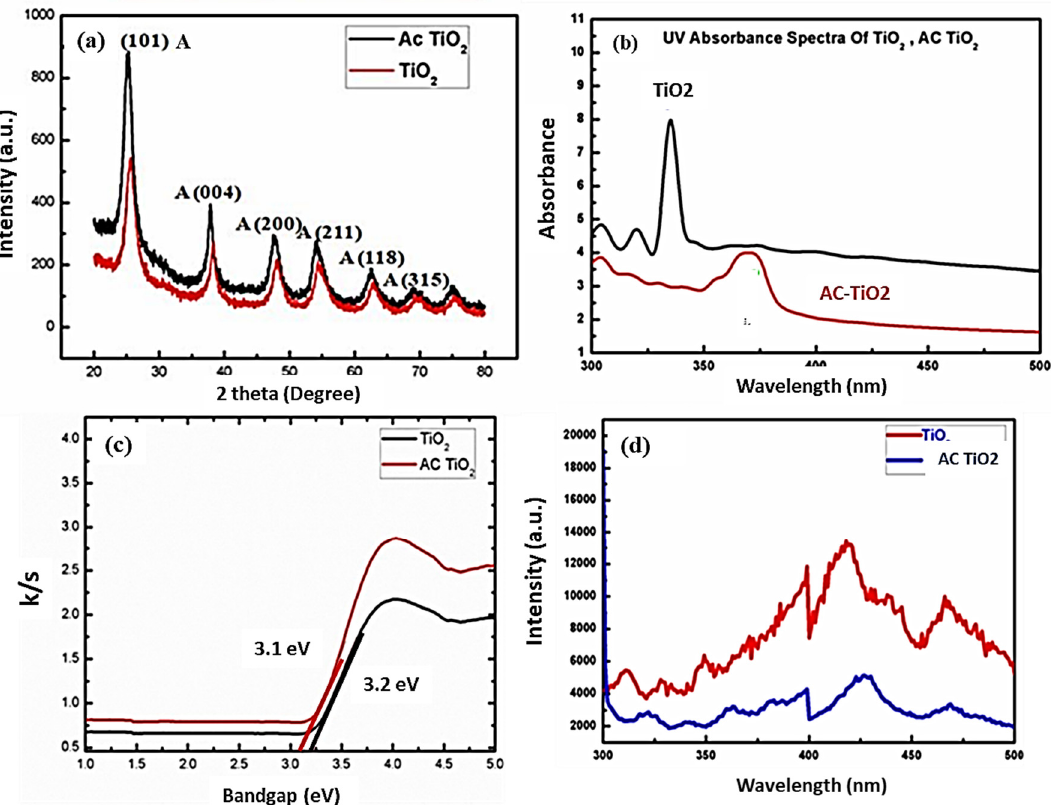
Figure 1. ( a ) XRD profile for unsupported TiO 2 and AC-TiO 2 , ( b ) optical absorption (UV-Vis) curve for TiO 2 and AC-TiO 2 , ( c ) UV-Visible study (DRS) of TiO 2 and AC-TiO 2 and ( d ) photoluminescence response for pure TiO 2 and AC-TiO 2 structure.